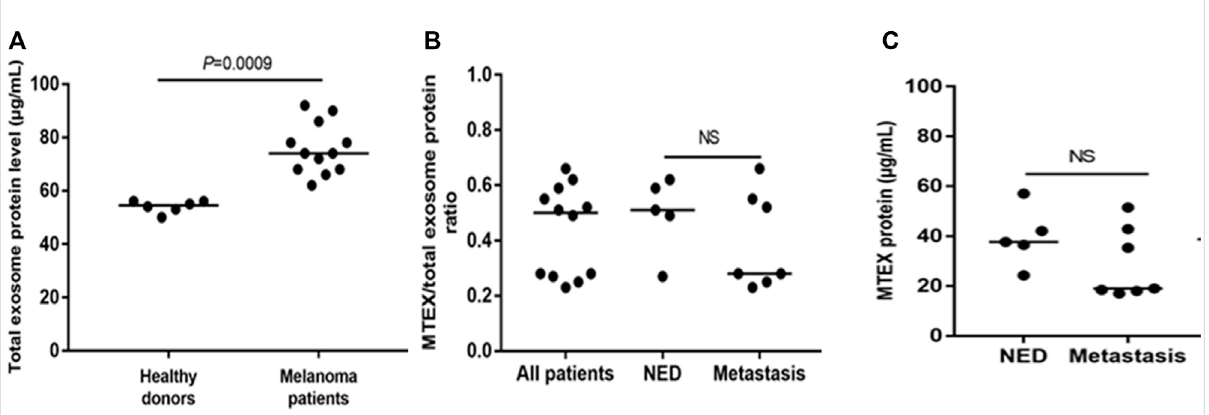
FIGURE 2 Protein levels in total plasma exosomes of melanoma patients or HDs and in isolated MTEX. In (A) , total exosome protein (TEP) levels in plasma of HDs or melanoma patients. In (B) , the total MTEX/TEP ratio for all patients vs. patients with NED or with progressive disease following oncological therapy. In (C) , protein levels in MTEX obtained from plasma of NED patients or melanoma patients with metastases (i.e., progressive disease following